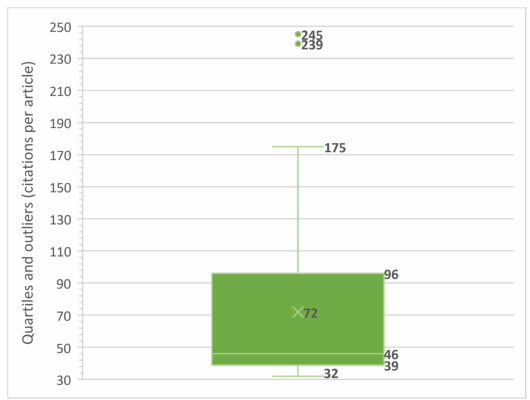
Figure 2. Box plot citations per h-index articles.